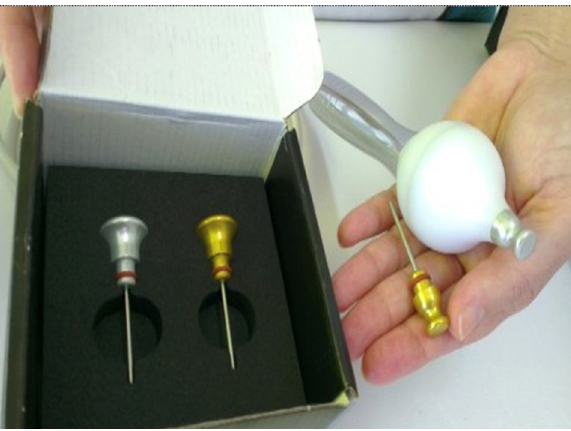
Figure 1 - Details of the electrodes used in the radiowfrequency apparatus Spectra G3 Tonederm®.